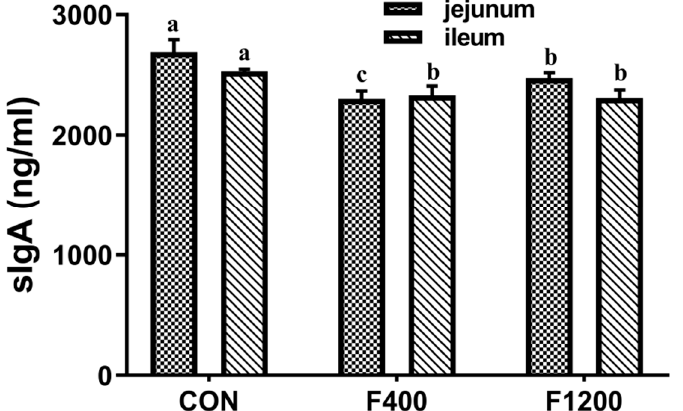
Figure 4. Effect of dietary fluoride levels on the contents of sIgA in jejunum and ileum of laying hens ( n = 6 in each group). Values were showed as the means and SD ( n = 6). ( a – c ) Mean without common letters above the histogram differ significantly ( p < 0.05). sIgA, Secretory immunoglobulin A. CON, the control group, basal diet; F400 and F1200, diets supplemented with 400, and 1200 mg F/kg feed from sodium fluoride, respectively.